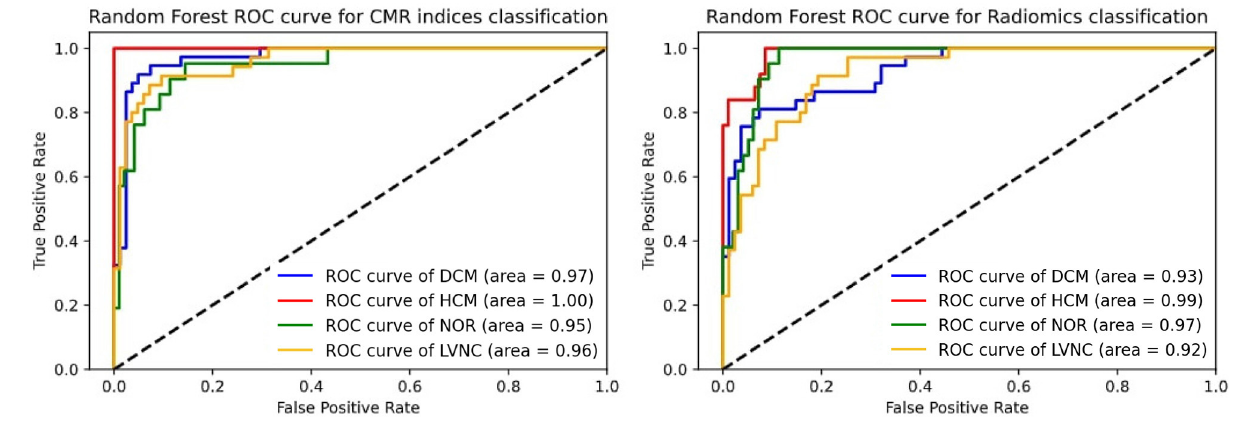
FIGURE 2 | Roc curve comparison for differential diagnosis. The left subfigure represents the CMR indices ROC curve. The right subfigure represents the radiomics ROC curve.